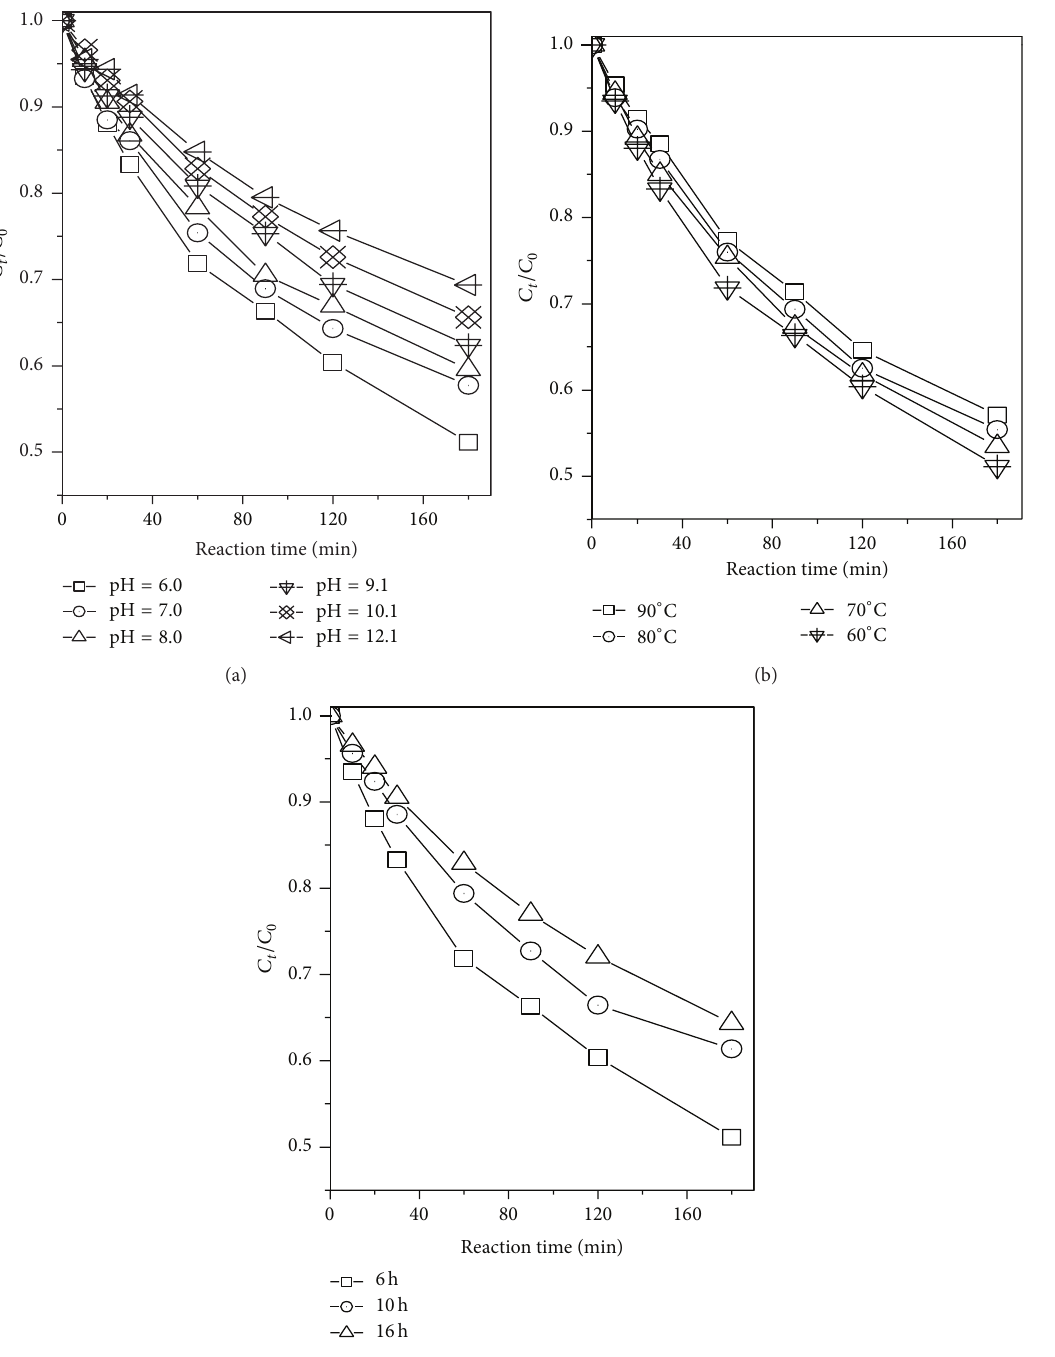
particle size. All the prepared 𝛾 -Fe 2 O 3 powders had signif- icant photocatalytic activities and achieved up to 48.89% removal and 36.5% mineralization of 20 mg/L of Orange I solutions under UV light irradiation. The 𝛾 -Fe 2 O 3 powders also had visible light photoactivities for Orange I